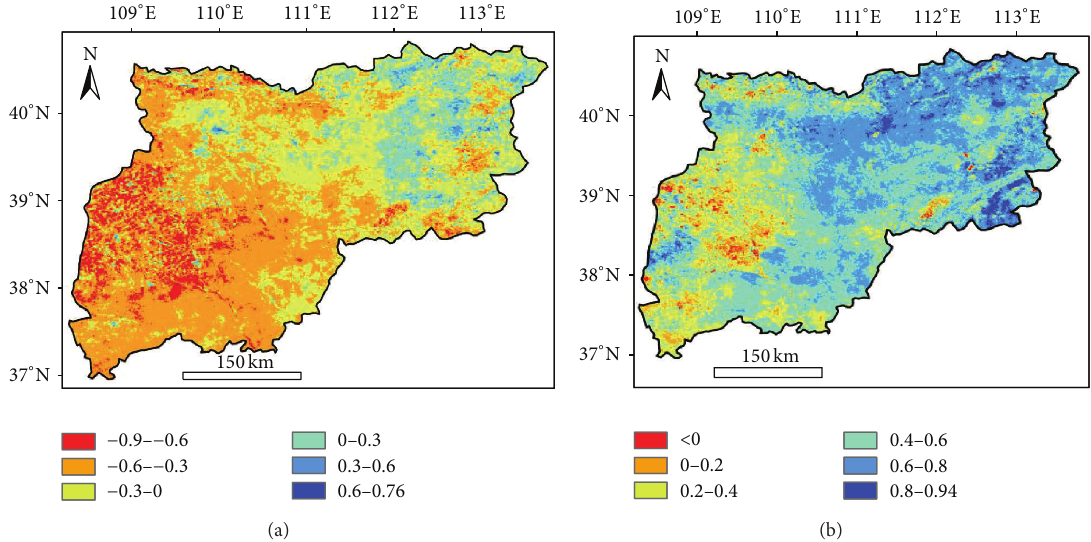
Figure 5: Correlation between the annual NDVI and annual (a) mean temperature and (b) precipitation on the northern Loess Plateau from 1998 to 2012.